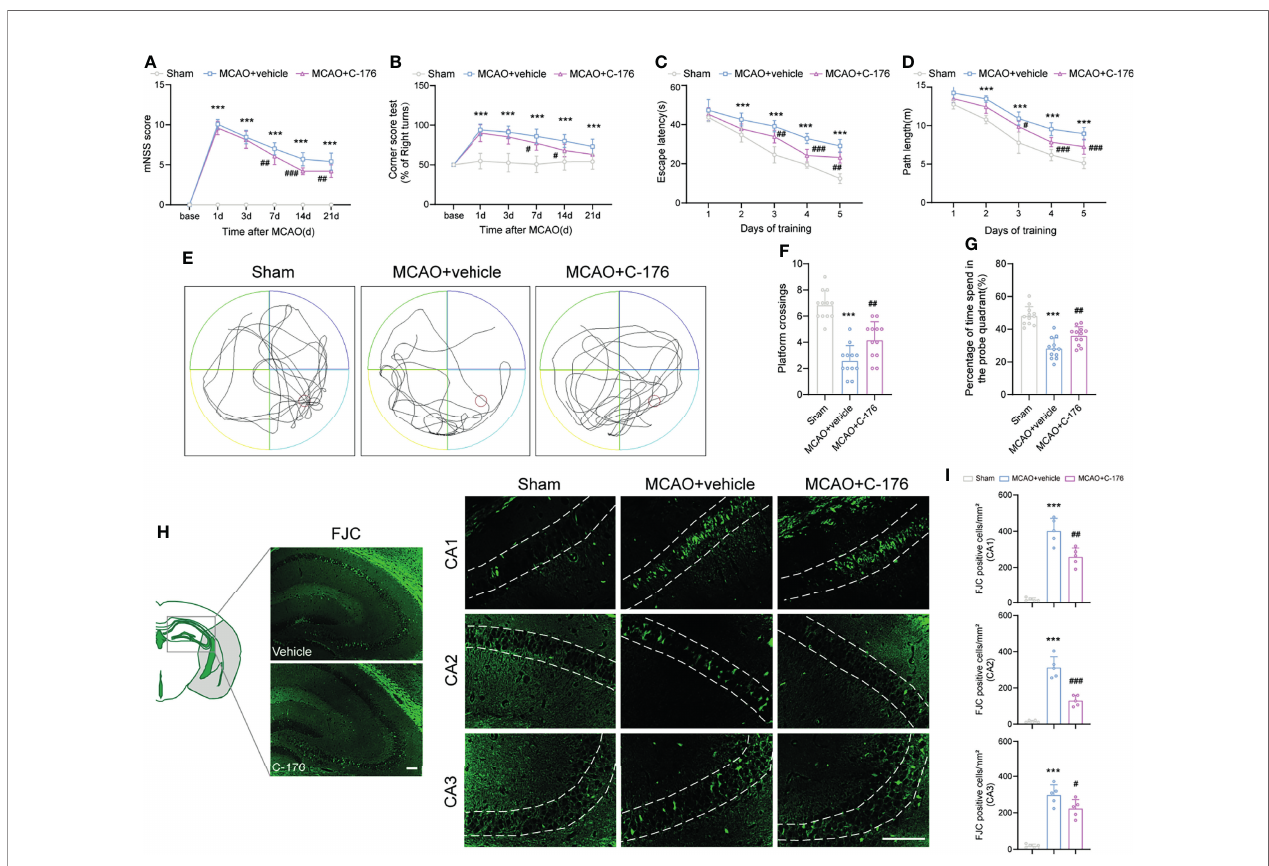
FIGURE 3 | Inhibition of STING improved neurological performance and cognitive function after MCAO. (A, B) The mNSS and Corner test were assessed at day 1, 3, 7, 14, and 21 after MCAO. Mice were tested before MCAO surgery. MCAO 1-7 d: n = 15; MCAO 14-21 d: n = 10. Long-term cognitive functions were assessed by the Morris water maze. (C, D) The escape latency and swim path length were recorded at days 22-28 after MCAO. n = 12. (E) Representative swimming trajectories of the three groups in probe trials. (F, G) The crossovers of the platform location and the percentage of time spent in the probe quadrant. n = 12. (H, I) FJC staining was performed to assess the neuronal degeneration in hippocampus at day 28 after MCAO. n = 5. Data are expressed as mean ± SD. *** P < 0.001 vs Sham group; # P < 0.05, ## P < 0.01, ### P < 0.001 vs MCAO+vehicle group. Scale bar = 100 m